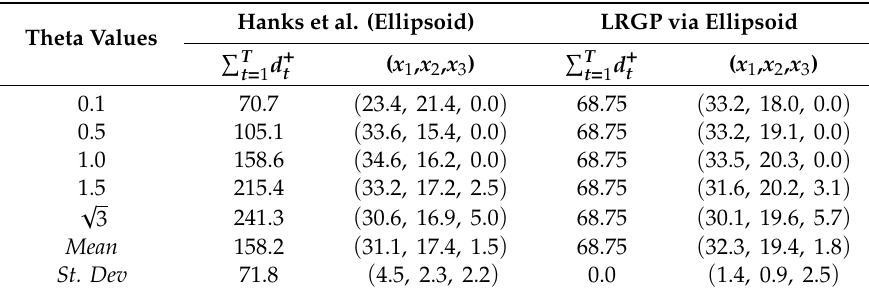
Table 5. Comparison of Hanks et al. (ellipsoid) and LRGP ( Γ -robustness)